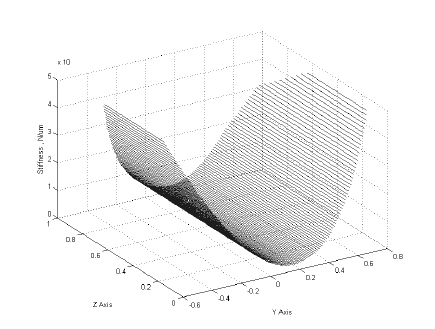
Figure 17: The Cartesian stiffness in the Y-direction as function of the Y- and Z-coordinates.